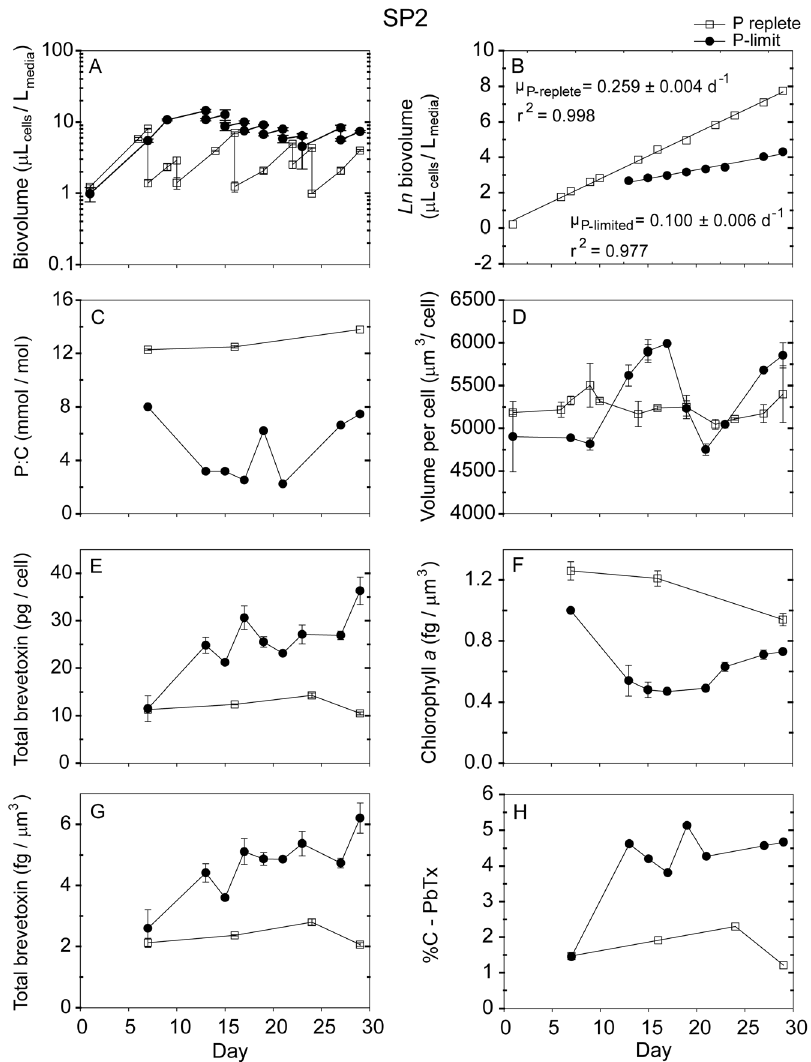
Figure 3. Time-dependent results from semi-continuous batch cultures of Kareniabrevis strain SP2 grown at nutrient-replete rates in high-P media (open squares) and grown into P-limitation in low-P media (filled circles). (A) Biovolume ( m L cells /L media ) plotted on a log scale vs. time, (B) Natural logarithm (ln) biovolume vs. time, correcting for culture dilution [39], (C) Cellular P:C ratios (mmol/mol), (D) Mean volume per cell ( m m 3 /cell), (E) Total brevetoxins per cell (pg/cell), (F) Chlorophyll a normalized to cell volume (fg/ m m 3 ), (G) Total brevetoxins normalized to cell volume (fg/ m m 3 ), (H) Percent of cellular carbon associated with brevetoxins (%C-PbTx). Error bars represent the standard deviation of triplicate measurements, except those normalized to carbon, where the cellular C was measured only in